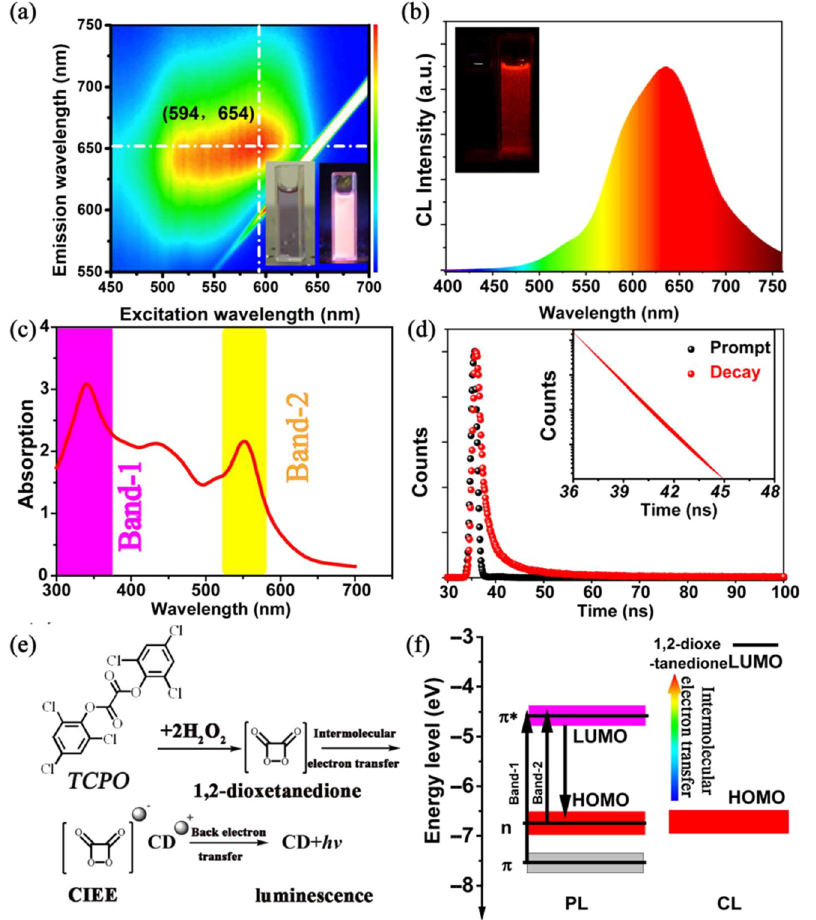
Figure2: (a)Excitation – emissionmatricesof the CDs aqueous solution (inset: the photograph of CDs aqueous solution under 365nmUVlamp).(b)TheCLspectrumofthe CDs (insets: the photograph before and after adding the CDs into TCPO and H 2 O 2 solution in dark); (c) UV – vis absorption spectrum of the CDs aqueous solution (inset: the photograph under sunlight). (d) Time-resolved decay spectrum of the CDs aqueous solution. (e) Schematic illustra- tion of the CL process inducedbythe CIEEL. (f) Schematic illustration the PL and CL